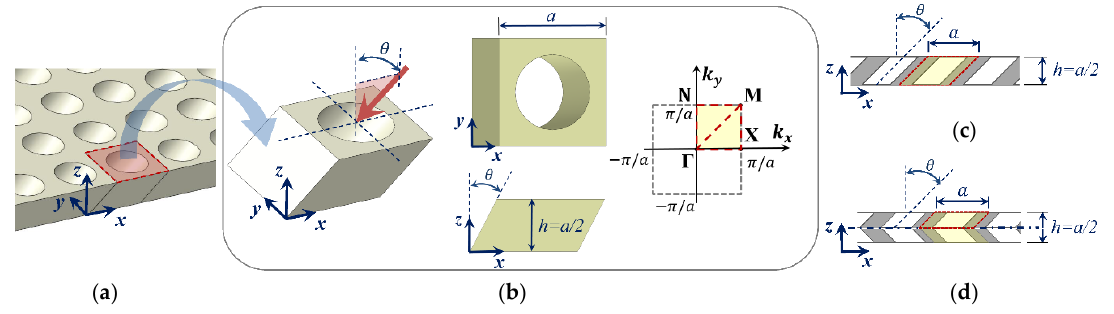
Figure 1. ( a ) Schematic of proposed obliquely perforated porous phononic crystal plates (OPhPs) produced by oblique perforation at an angle θ (about y-axis) on a uniform plate and ( b ) selected unit-cell and relevant irreducible Brillouin zone, and cross section of ( c ) an asymmetric OPhP (A-OPhP) and ( d ) a symmetric OPhP (S-PhP) lattice, respectively, with asymmetric and symmetric through-the-thickness